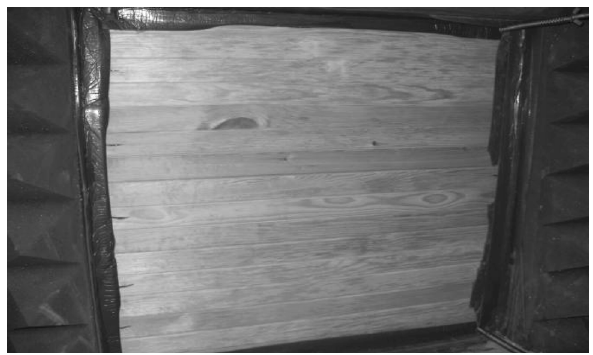
Fig. 5. Insulation coefficients D nT,w converted for each fre- quency band in the natural and the chamber studies